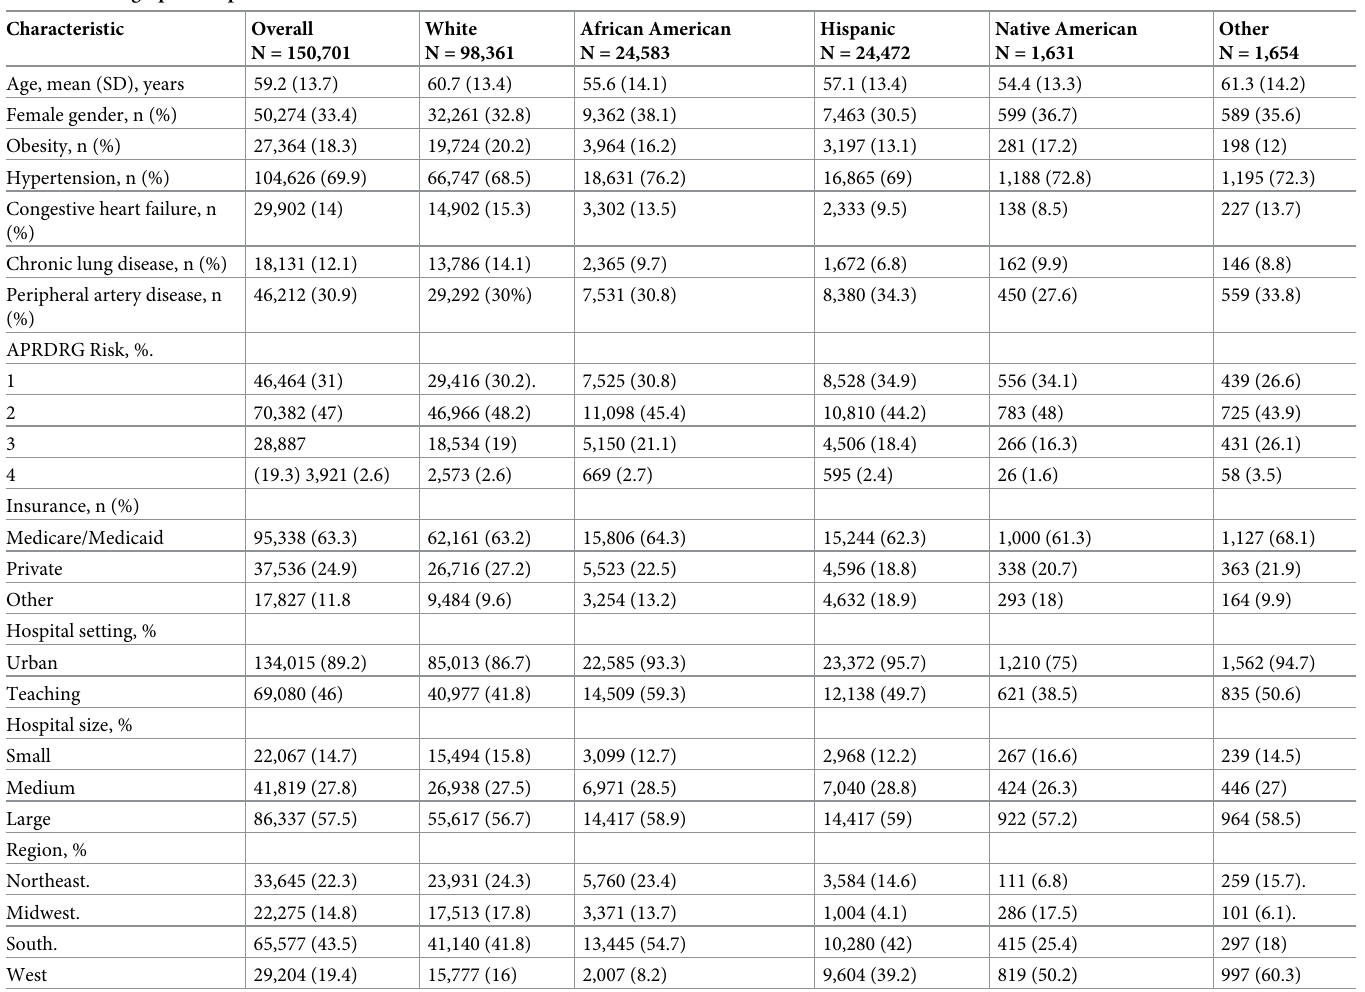
Table 1. Demographic for patients with diabetic foot infections.